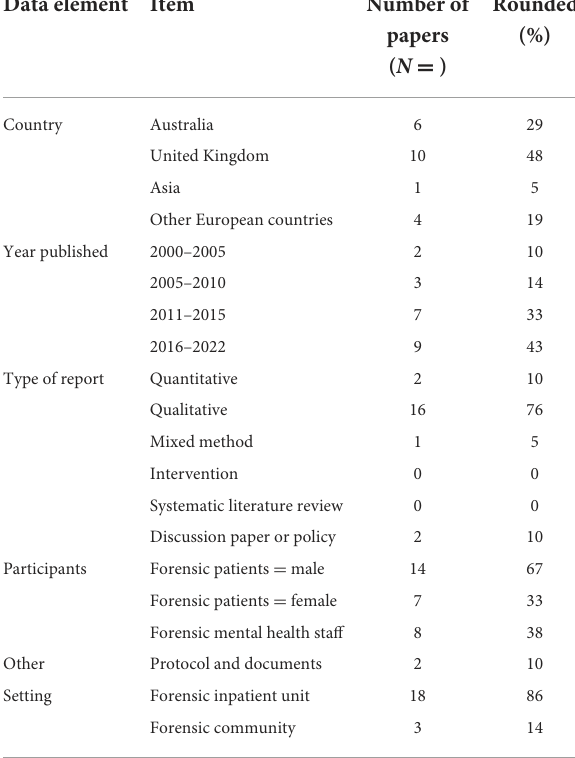
TABLE 2 Summary of report